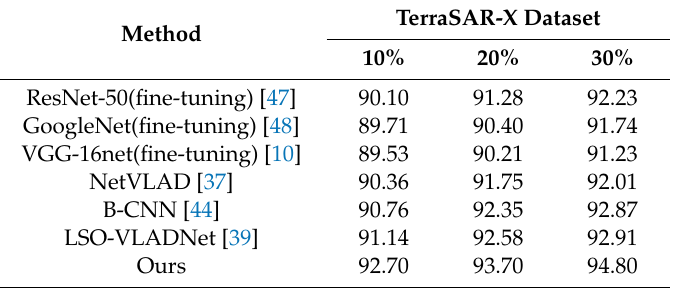
Figure 8. Comparison between the GCCH network and other state-of-the art methods on the TerraSAR-X dataset. ( a ) 10%. ( b ) 20%. ( c ) 30%. Table 3. The performance results compared with other state of the art